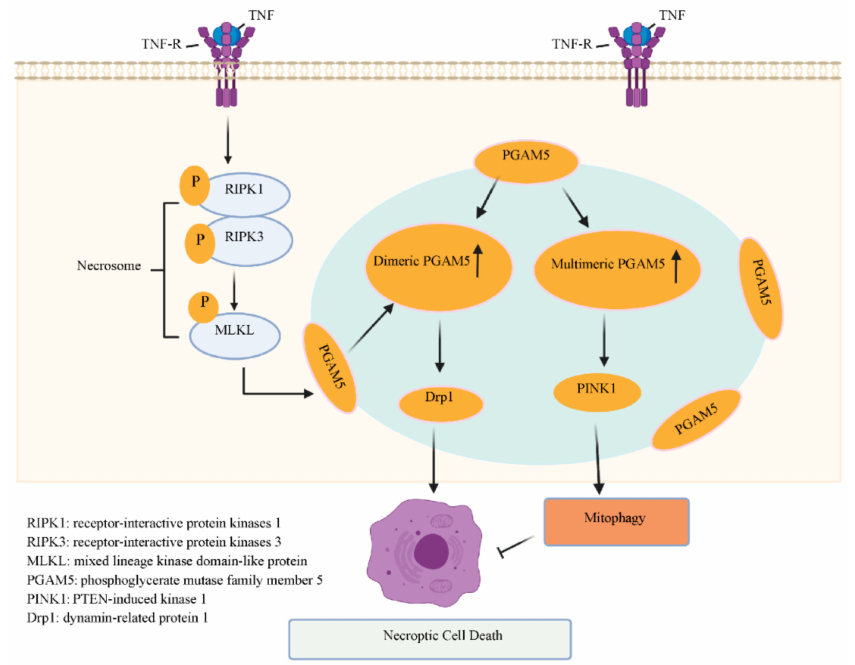
Figure 1. The double function of phosphatase phosphoglycerate mutase family member 5 (PGAM5) in necroptosis. A. After activation of death receptors, tumor necrosis factor signaling can instead induce activation of receptor-interactive protein kinases 1 (RIPK1) and receptor-interactive protein kinases 3 (RIPK3). RIPK3 phosphorylates binds to mixed lineage kinase domain-like protein (MLKL), causing generation of necrosomes. The RIPK1/RIPK3/MLKL necrosome shuttles to the mitochondrial membrane, where RIPK3, after phosphorylation, activates PGAM5 located on the outer membrane of mitochondria. The activated PGAM5 is recruited to mitochondria and activates dynamin-related protein 1, resulting in necroptosis. B. PGAM5/PTEN-induced kinase 1 (PINK1)-mediated mitophagy causes the accumulation of abnormal mitochondria leading to the overproduction of reactive oxygen species, which worsens